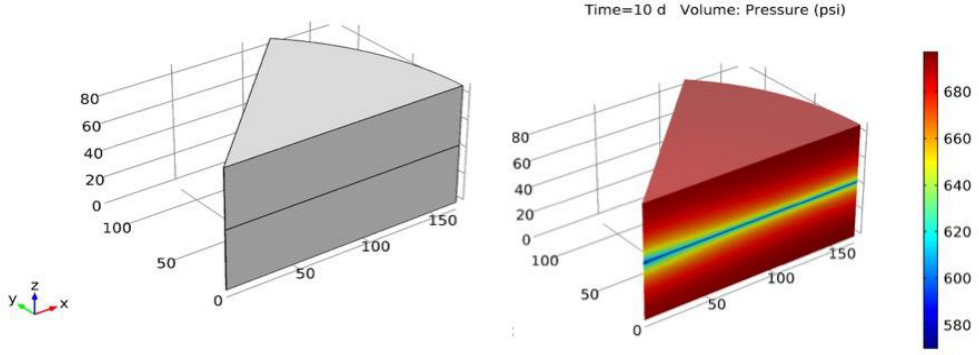
Figure 3. ( Left ): Geometry of case 2 showing one lateral (Phase angle = 90 ◦ ). ( Right ): pressure profile after 10 days of simulation.